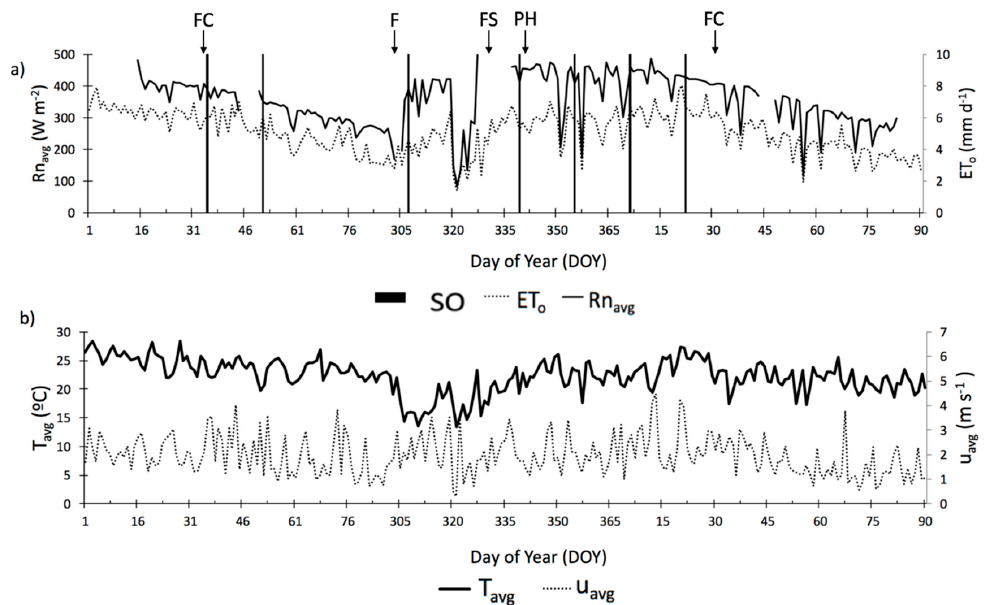
Figure 1. ( a ) Daily variation of net radiation (Rn avg ) and reference evapotranspiration (ET o ); ( b ) average daily values of temperature (T avg ) and average daily values of wind speed (u avg ). The vertical bars indicate the time of satellite overpass (SO). Also, phenological stages are indicated by an abbreviation followed by an arrow where F = flowering, FS = fruit Set, PH = pit hardening and FC = fruit colouring. Table 2. Meteorological conditions during the study